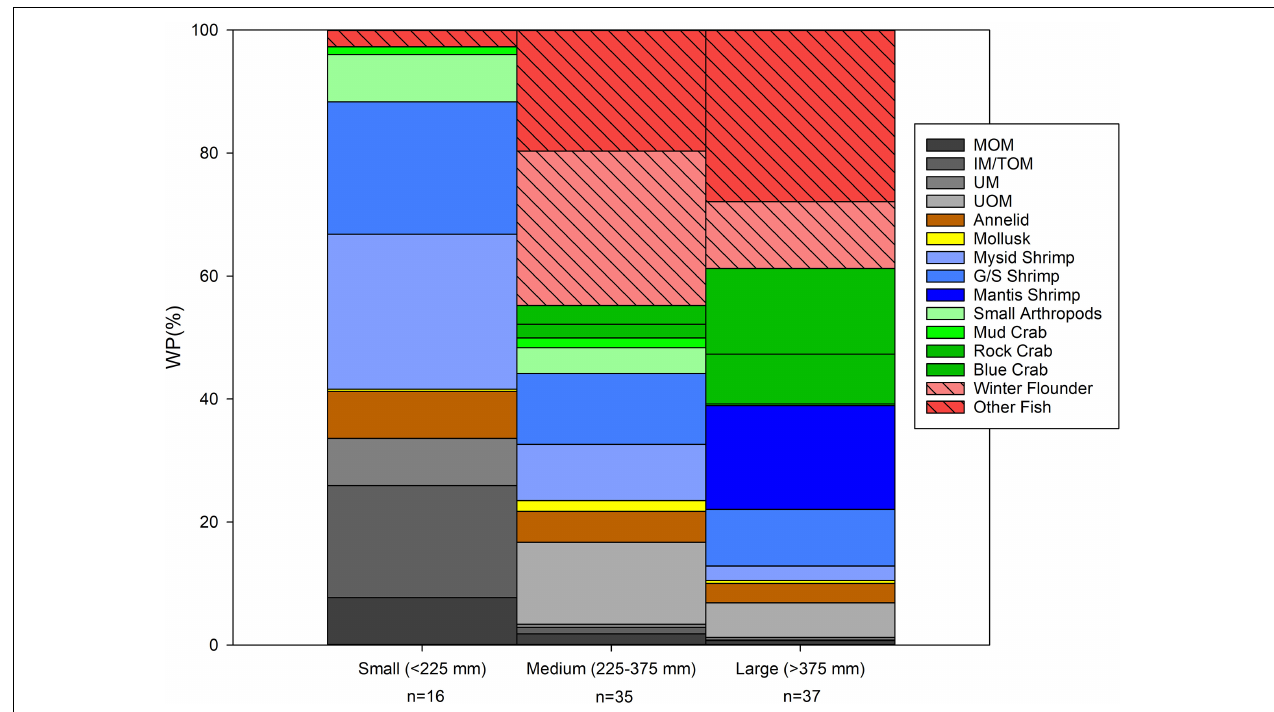
FIGURE 4 | Diet composition (percent by weight) of summer flounder collected in Shinnecock Bay (2014–2016) by size class [small ( < 225 mm), medium (225–375 mm), and large ( > 375 mm)]. To ease graphic representation of the data, closely related prey items were grouped into higher taxonomic levels such as “other fish” or “small